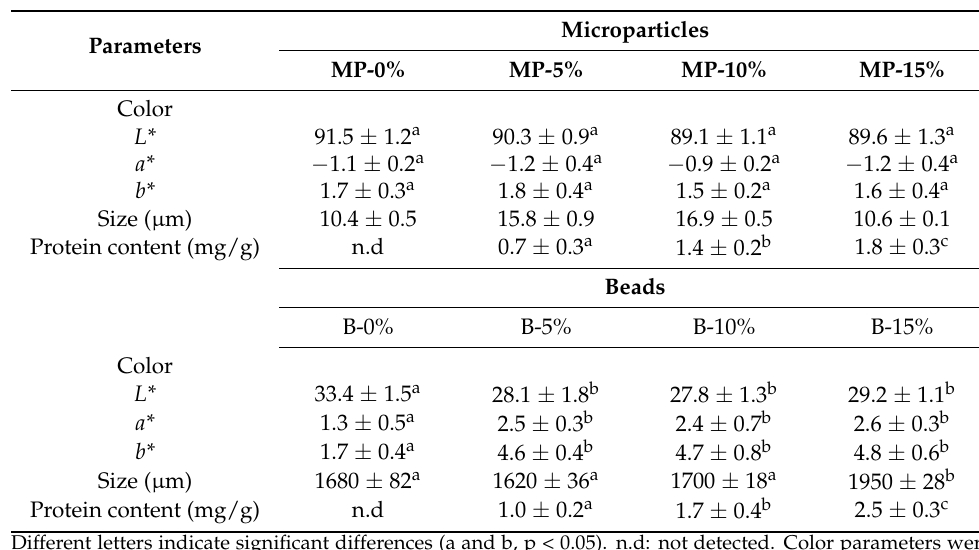
Table 2. Characteristics of microparticles (MP) and beads (B) with different concentrations of cochleates of S. Infantis (0–15% v/v).